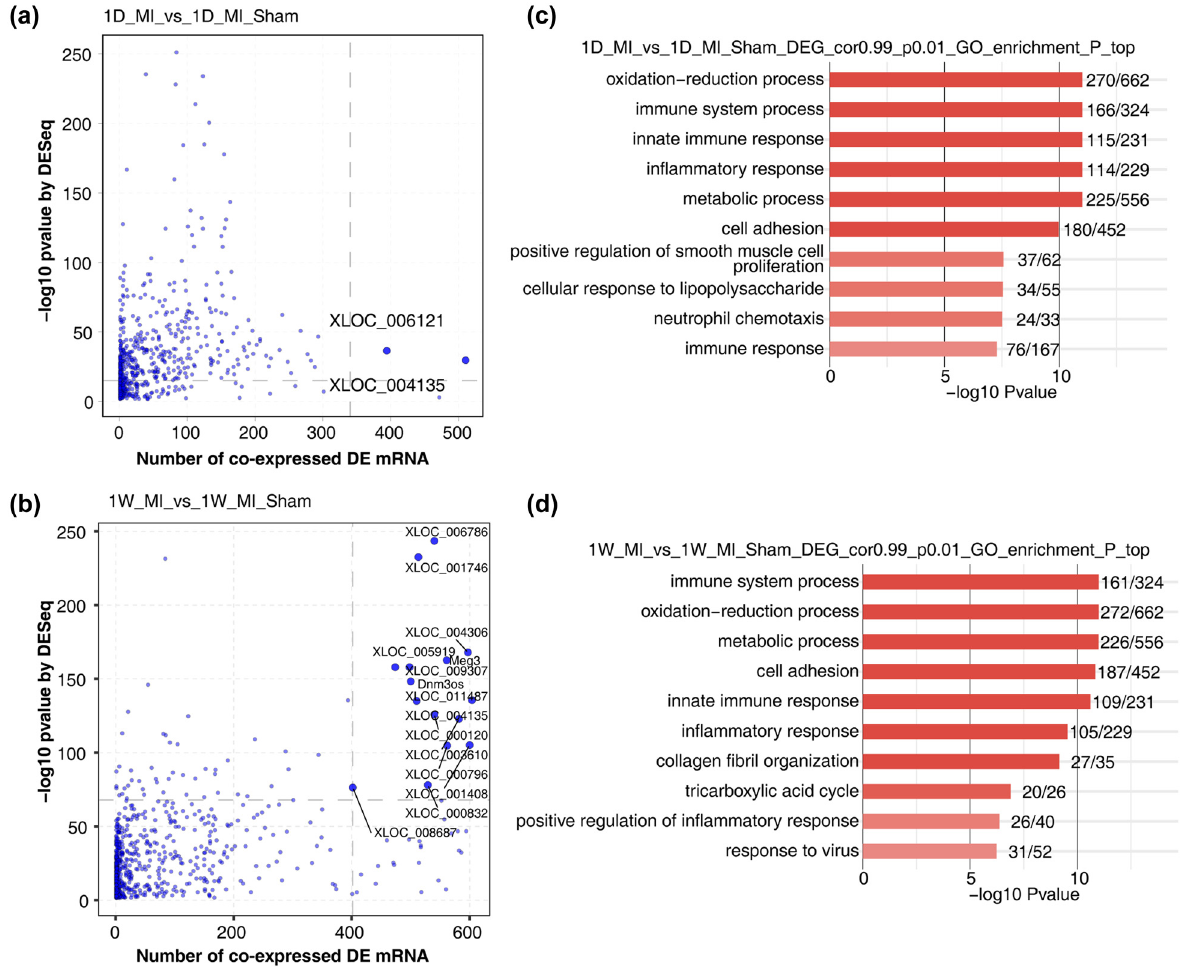
Figure 4: Coexpression network illustration between DE lncRNAs and DE mRNAs. ( a and b ) Scatter plot shows DE lncRNAs by MI compared with sham samples and the number of coexpressed DE mRNAs. Red points denote upregulated lncRNAs involved in coexpression pairs, and blue points denote downregulated lncRNAs. Cuto ff s of P - value < 0.01 and Pearson coe ffi cient > 0.99 were applied to identify the coex - pression pairs; ( c and d ) top 10 most enriched GO biological process pathways by DE lncRNAs coexpressed with DE mRNAs of MI compared with Sham